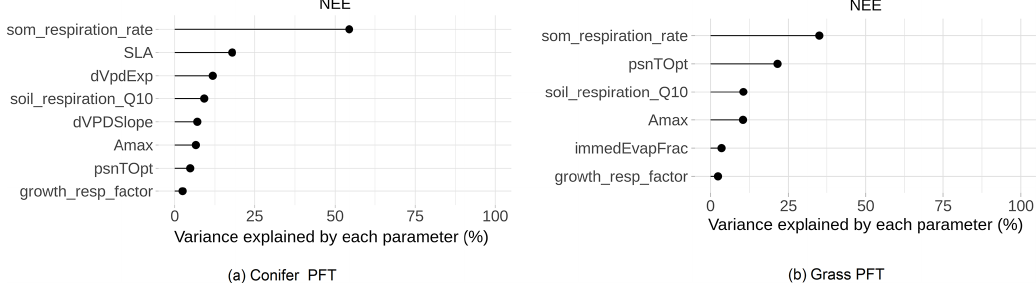
Figure 5. Global sensitivity analysis of SIPNET model parameters to NEE prediction for different plant functional types.